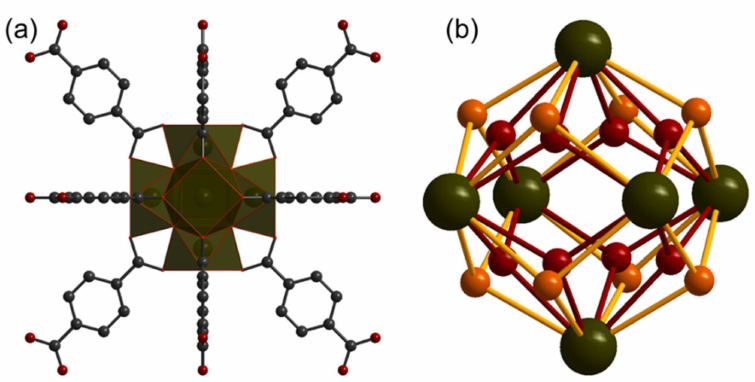
Figure 1. Schematic representation of the UiO-66 structure according to crystallographic data COD ID 4512072. ( a ) Dark green polyhedral represents the Zr-O cluster; gray spheres represent carbon atoms, dark red represents for oxygen. ( b ) Schematic representation of Zr 6 O 4 (OH) 4 SBU. Both oxygen positions are provided: µ 3 -O (dark red) and µ 3 -OH (orange). Oxygen atoms can alternate to occupy each of them The picture was prepared in Diamond, version